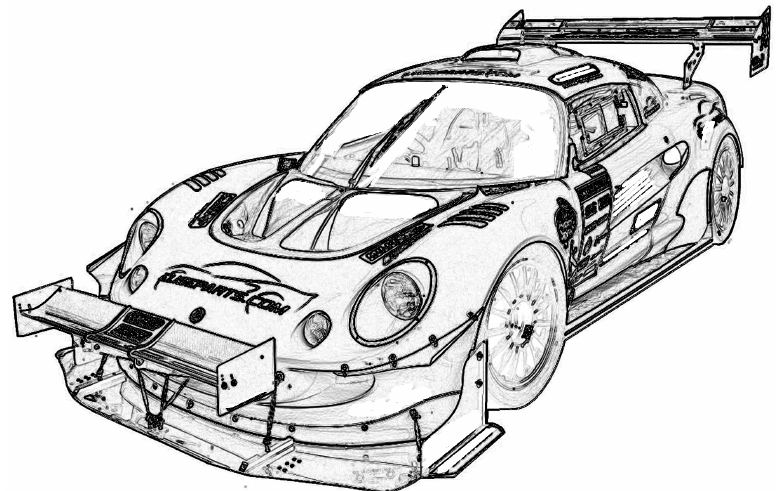
Figure 4. Lotus Elise with mid-height front wing.